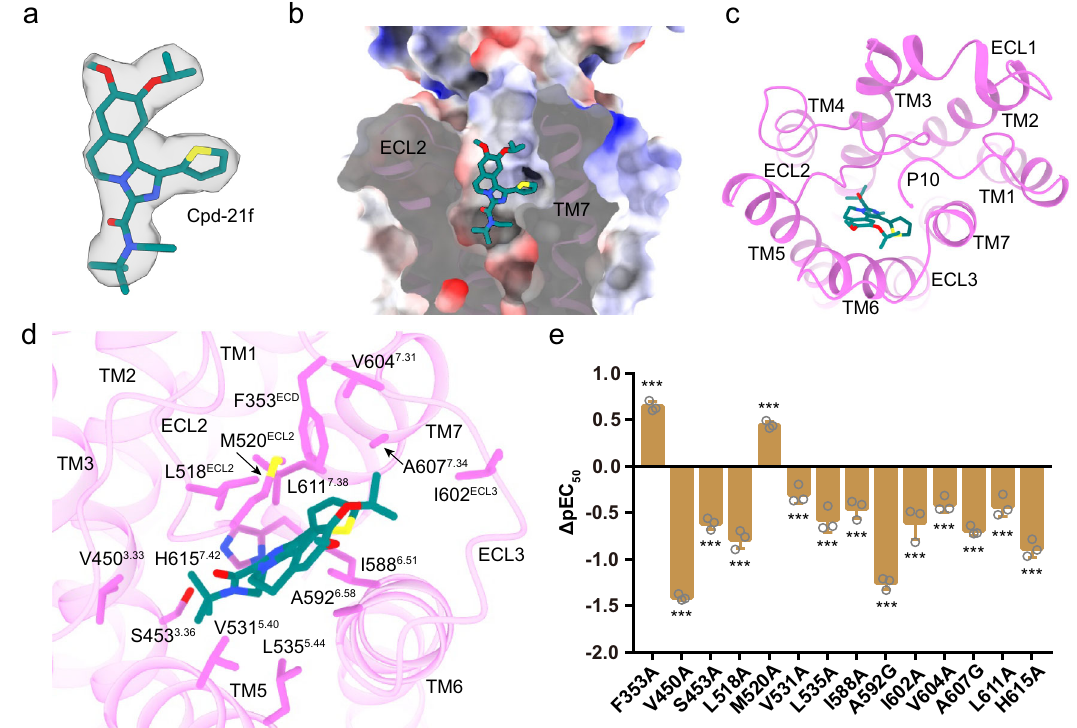
Fig. 4 | Structural basis for FSHR activation by an allosteric agonist Cpd-21f. a ThestructureandEMdensityofCpd-21fintheboundstructure.Thedensitymap isshownatlevelof0.17. b , c ThebindingpocketofCpd-21finFSHR,fromthefront view ( b ) and top view ( c ). d Detailed interactions between Cpd-21f and FSHR. e Effects of different pocket mutations on the potency of Cpd-21f-induced cAMP accumulation. Data were shown as Δ pEC 50 ±S.E.M. from three independent